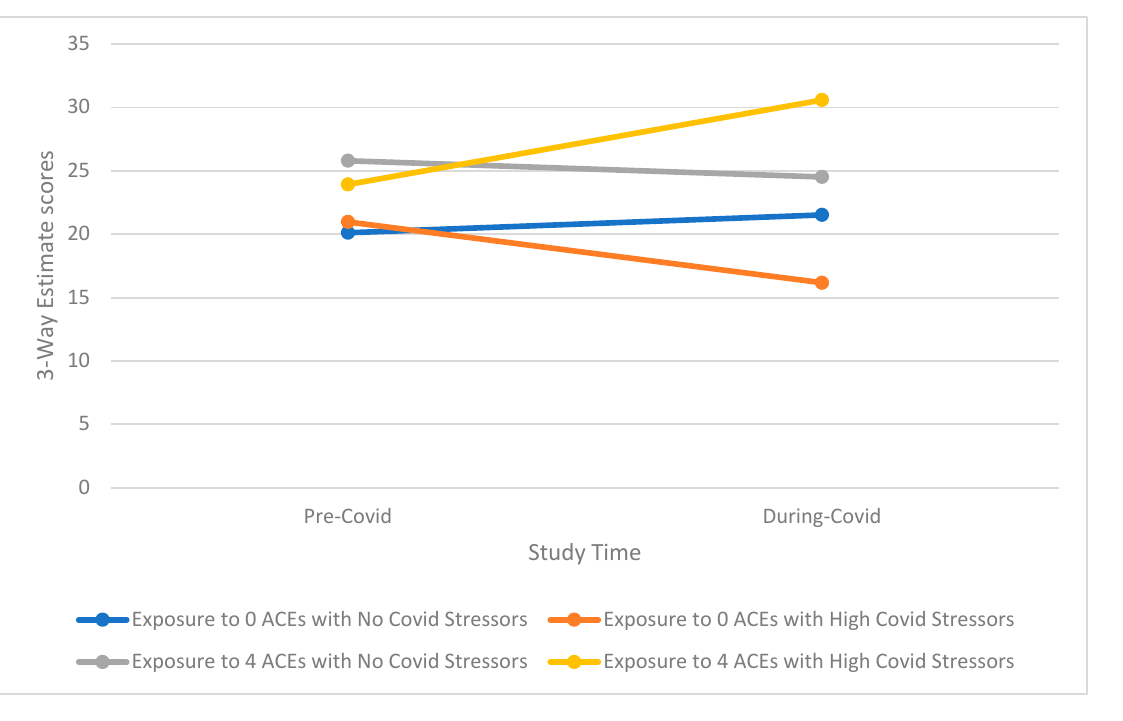
Figure 5. Interaction of greater exposure to ACEs and increased levels of Alcohol Consumption on Changes in Perceived Stress Symptomatology among Young Adults from Before to During the COVID-19 Pandemic.